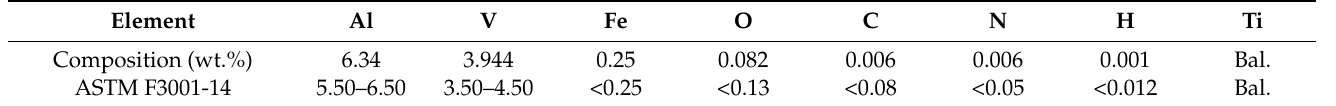
Table 1. The chemical composition of the Ti6Al4V(ELI) as received from the supplier and that specified in the ASTM F3001-14 standard